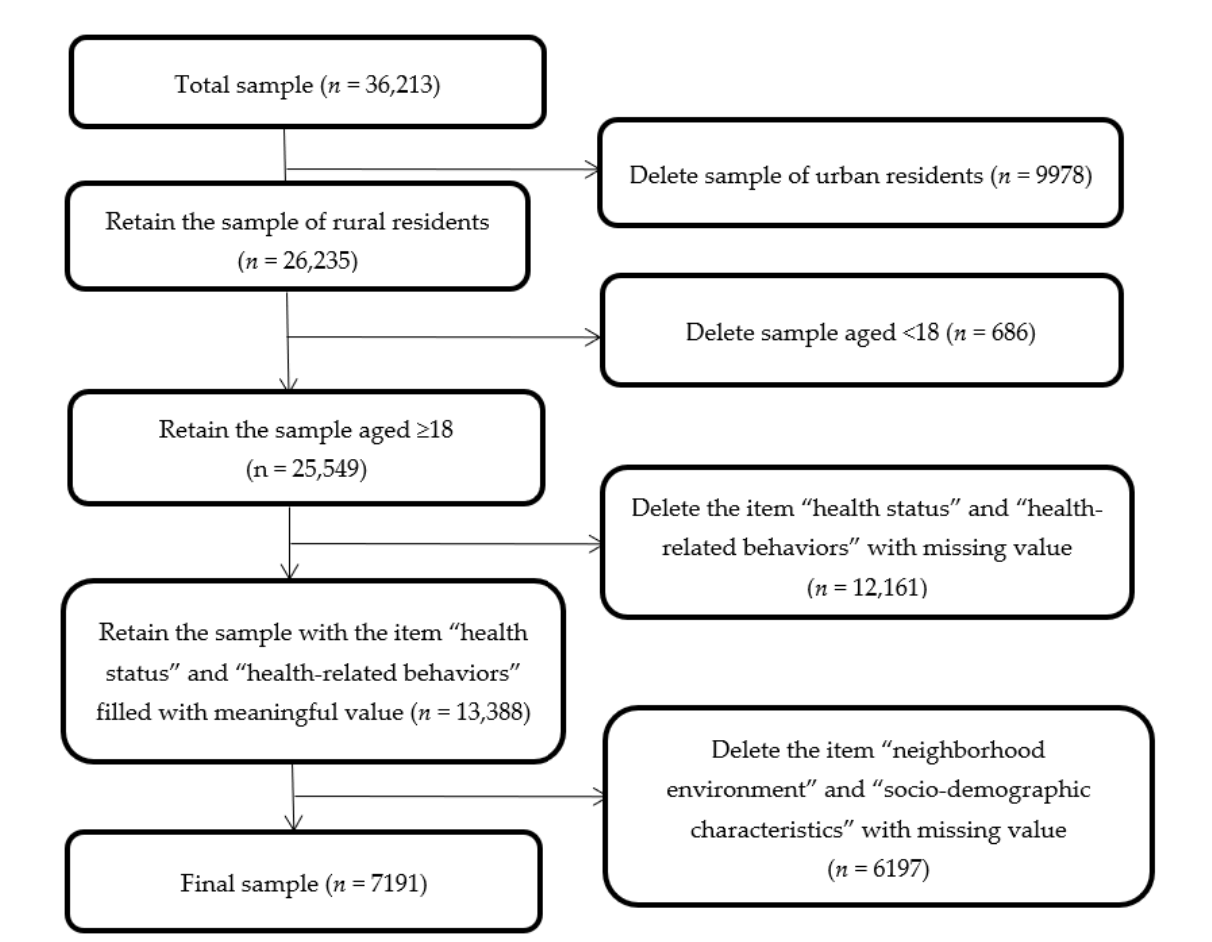
Figure 1. Study sample selection process.